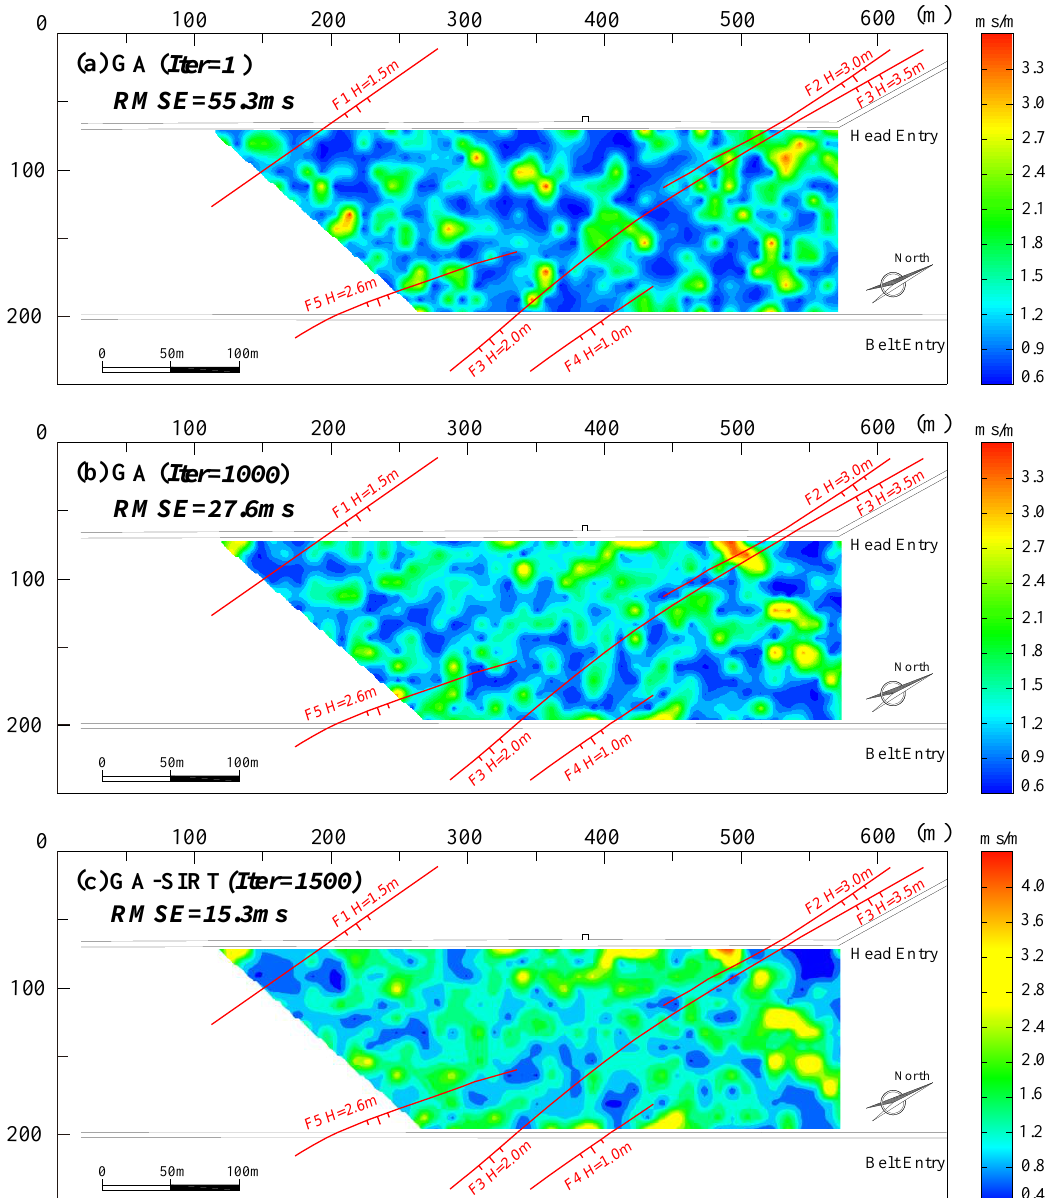
Figure 4. Inversion results of slowness. ( a ) Initial model with iterations Iter = 1; ( b ) result from the genetic algorithm (GA) inversion after 1000 iterations; ( c ) final result from the application of simultaneous iterative reconstructive technique algorithm (SIRT) tomography after 500 iterations;